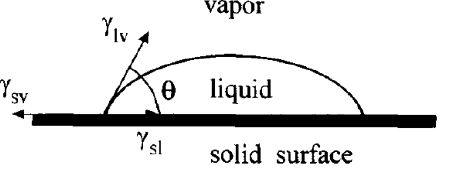
Figure 1. Definition of contact angle (Reprinted with permission from Ref. [16]. 1996, Li, D.Q.).